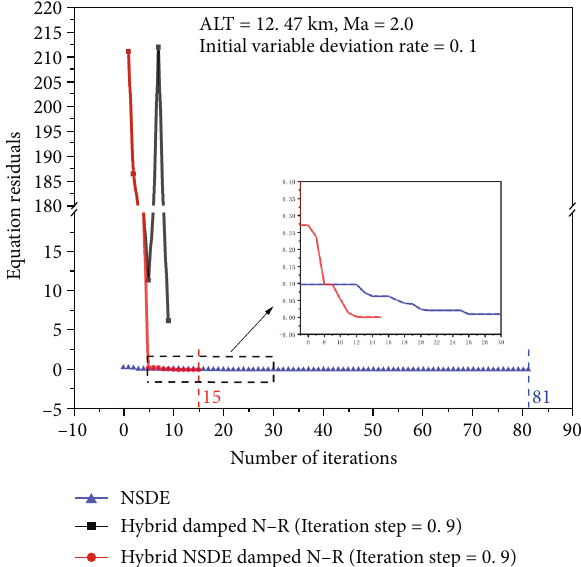
10: Variation of equation residuals with the number of component calculations for di ff erent iterative algorithms under Alt = 12 : 47km and Ma = 2 : 0